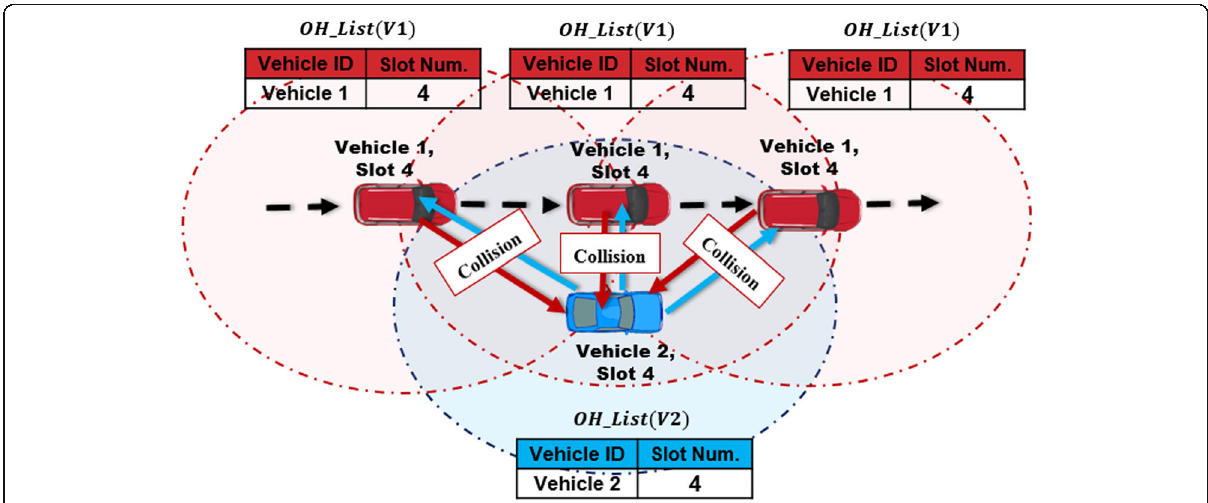
Fig. 6 Detection failure scenario “ access collision case